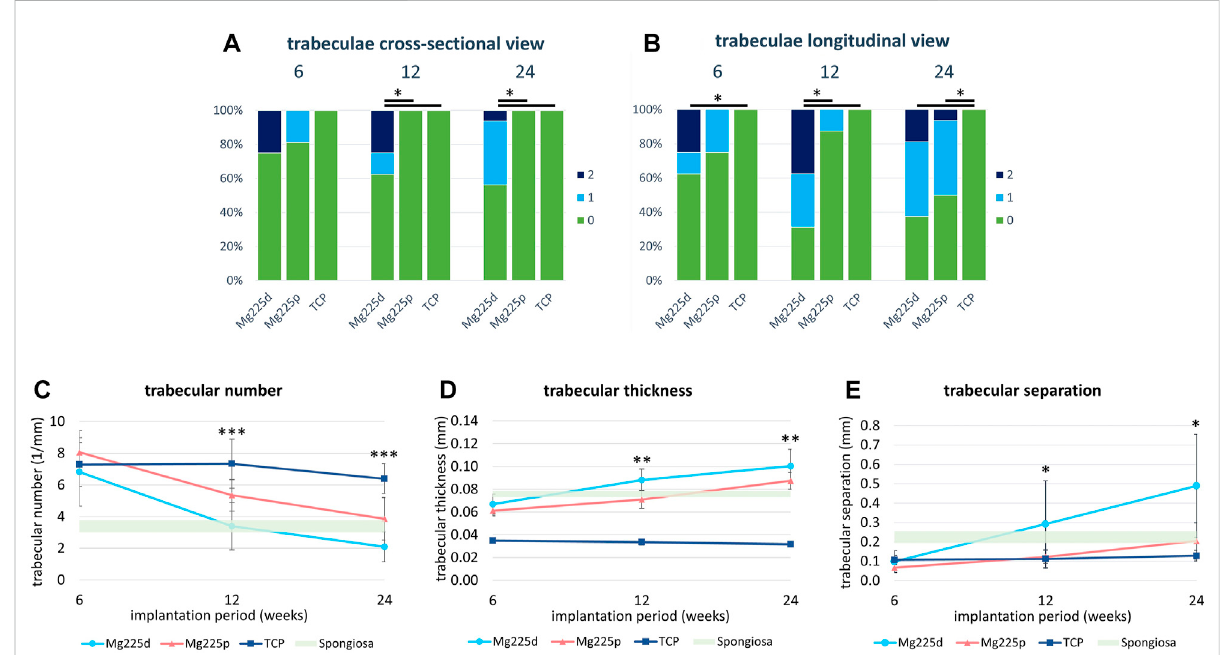
FIGURE 7 (A,B) Semi-quantitativeµCT80evaluationofnewlyformedbonetrabeculaewithintheinitialscaffoldvolume (A) incross-sectionalviewand (B) in longitudinal view 6, 12 and 24 weeks after surgery. *: Signi fi cant differences ( p < 0.05) between the individual materials. (C – E) Quantitative µCT 80evaluationof (C) trabecularnumber(Tb.N), (D) trabecularthickness(Tb.Th)and (E) trabecularseparation(Tb.Sp)ofnewlyformedbonetrabeculae within the initial scaffold volume compared to native cancellous bone of the lateral femoral condyle. Signi fi cant differences ( p < 0.05) are marked with *: Mg225d — TCP, **: CMPCs — TCP, ***: all